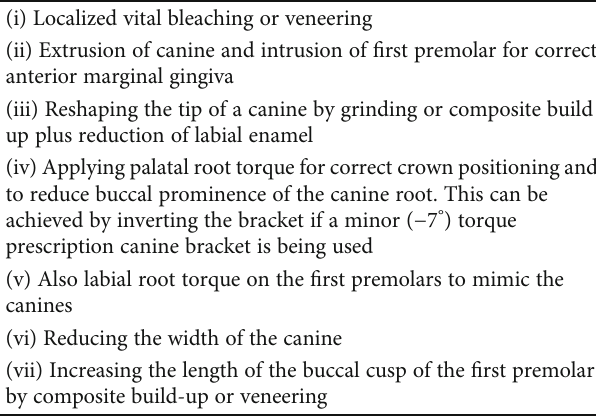
Table 2: Optimizing dental aesthetics when a maxillary canine is substituting for a lateral incisor and 1 st premolar is substituting for a